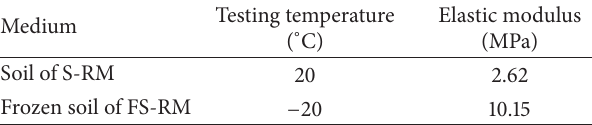
Table 2: Elastic modulus of soil and frozen soil. Figure 9: TAJ–2000 large static triaxial test apparatus.